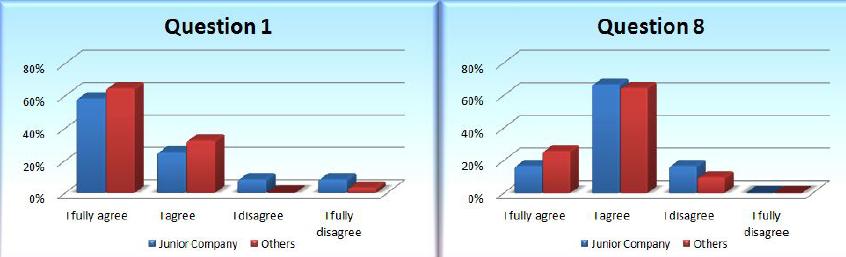
Fig. 5. Comparison between the answers of the two groups to question 1 and question